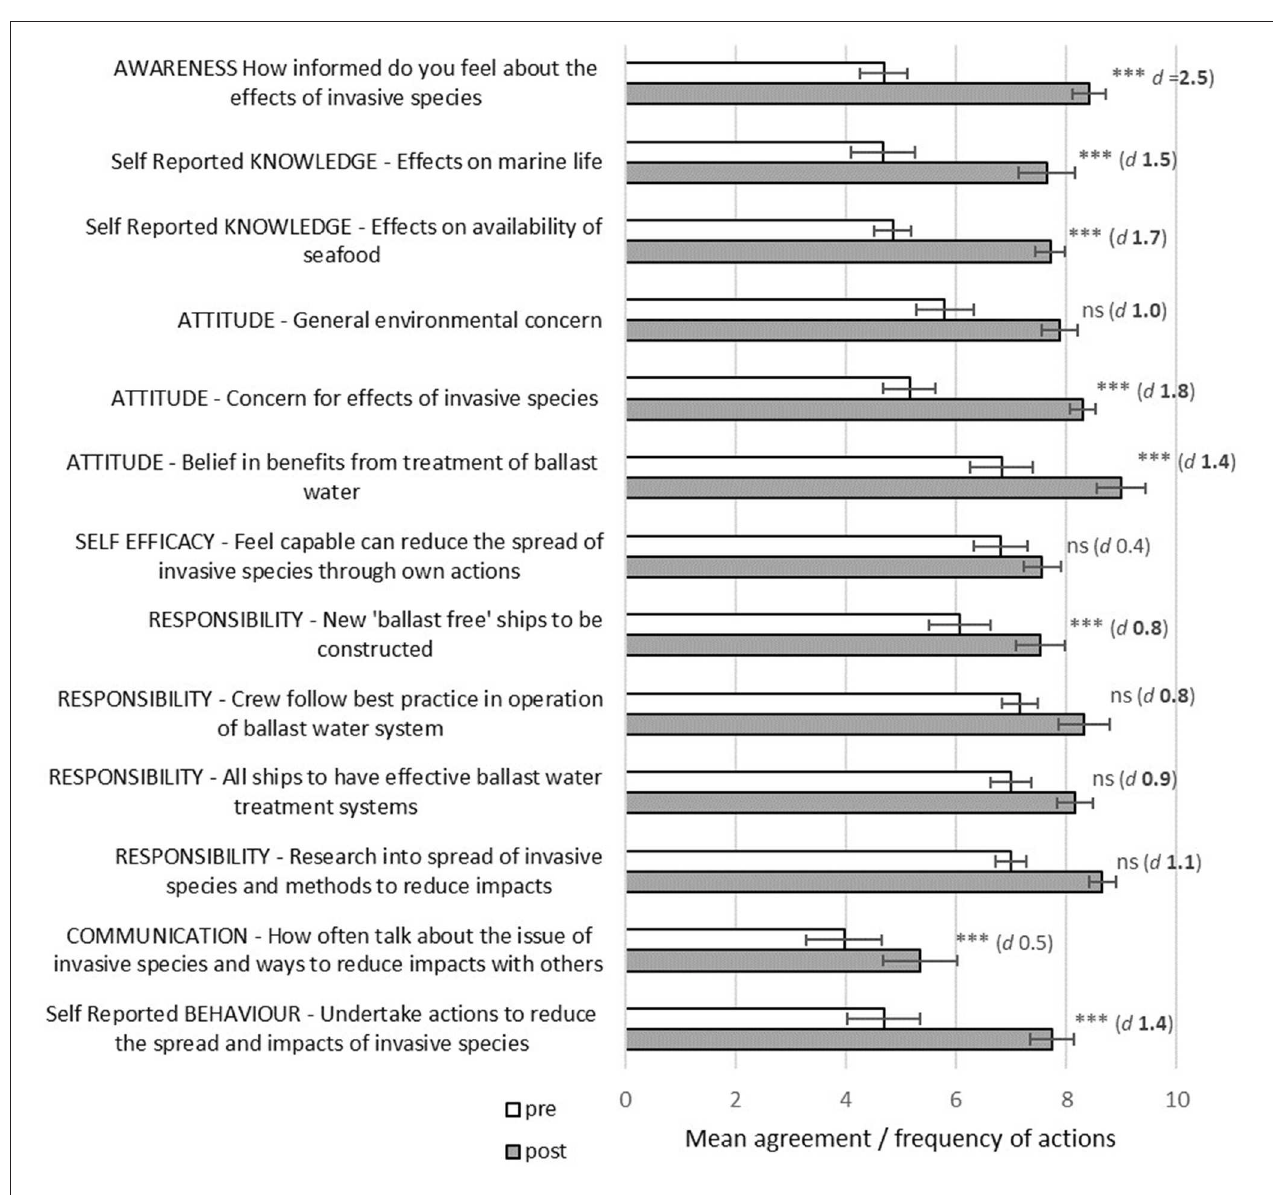
FIGURE 1 | Mean participant responses to pre and post surveys completed before and after participating in the “Sustainable Seafaring” course, significant differences ( p ≤ 0.005) between pre and post surveys are indicated by ***, effect size (Cohen’s d) of medium or above are in bold ( d = #